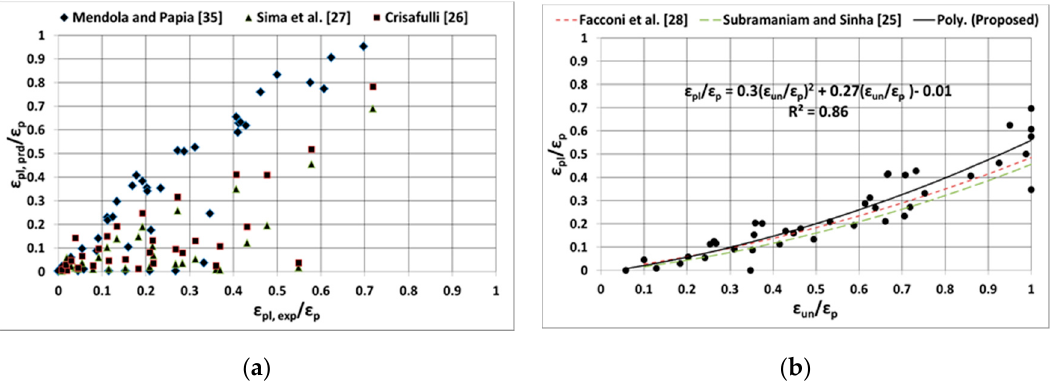
Figure 6. Comparison of experimental and analytical plastic strains ( a ) Mendola and Papia [35], Sema et al. [27] and Crisafulli [26] and ( b ) Facconi et al. [28] and Subramaniam and Sinha